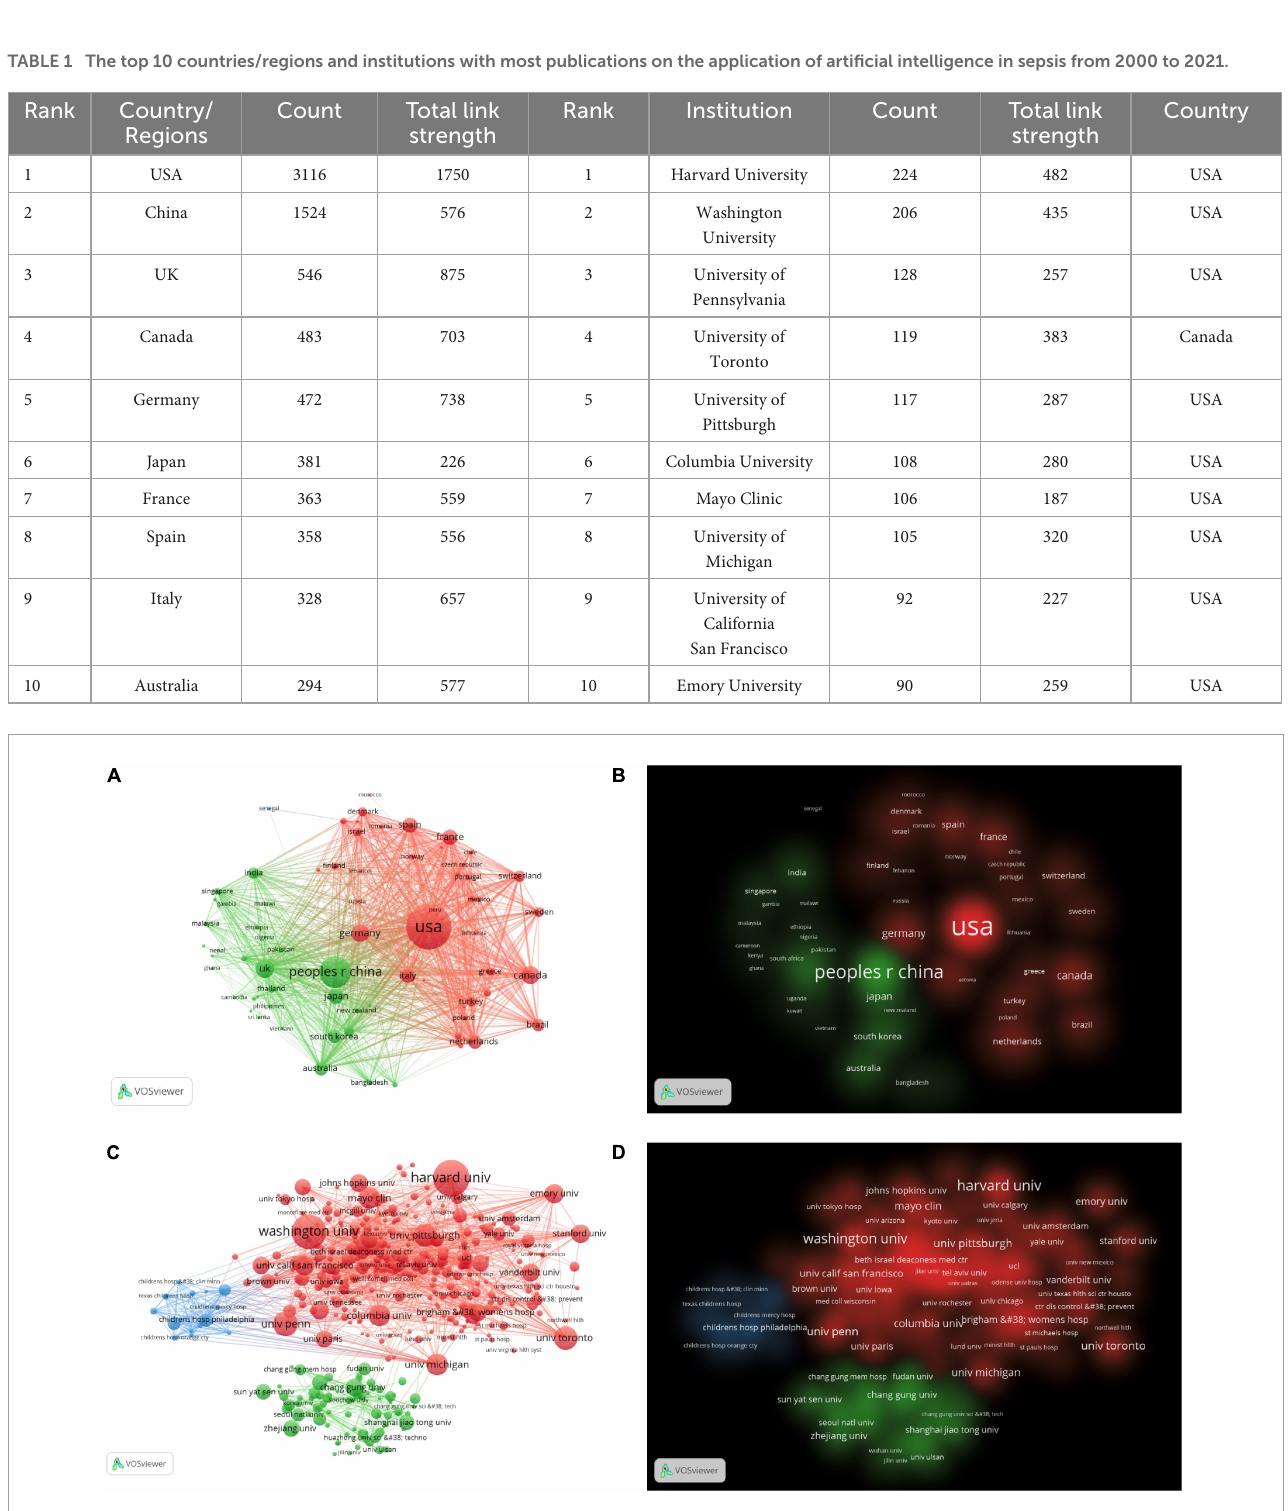
FIGURE3 (A) The citation network visualization map of countries/regions. (B) The citation density visualization map of countries/regions. (C) The citation network visualization map of institutions. (D) The citation density visualization map of institutions.